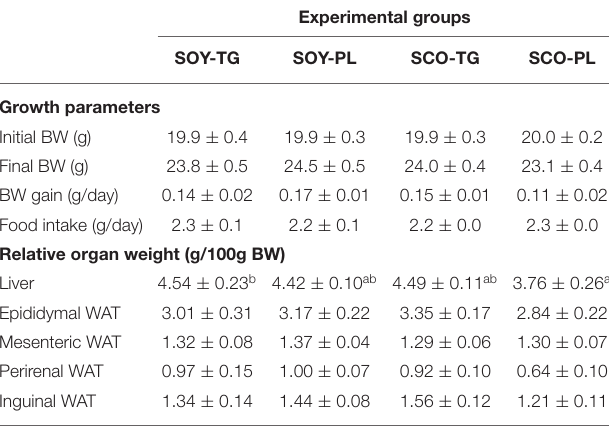
TABLE 4 | Growth parameters and relative organ weights.